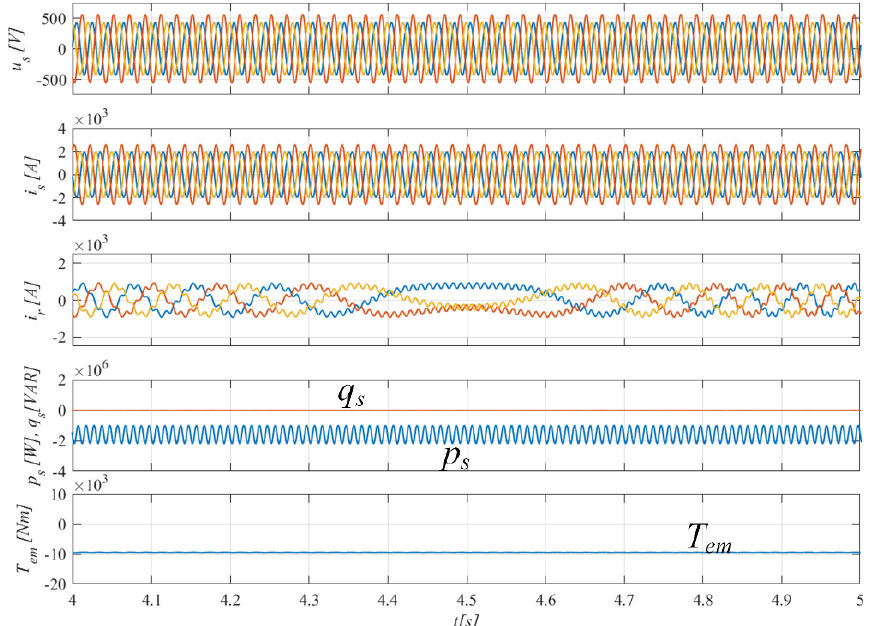
Figure 14. Simulation results of DPC in case of asymmetrical grid voltage with the feedforward and decoupling mechanism and included rotor current information in control. Variable speed operation, change from sub-synchronous to super-synchronous speed, Q sref = 0, T emref = − 9.5 kNm. The control allows to maintain constant torque operation for a vast range of speed variance.